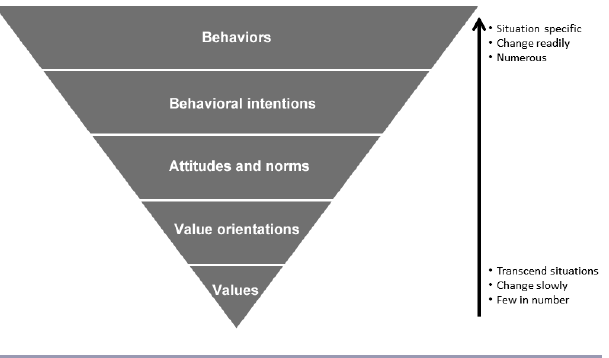
Fig. 1 . Cognitive hierarchy model of human behavior, adapted from Fulton et al.